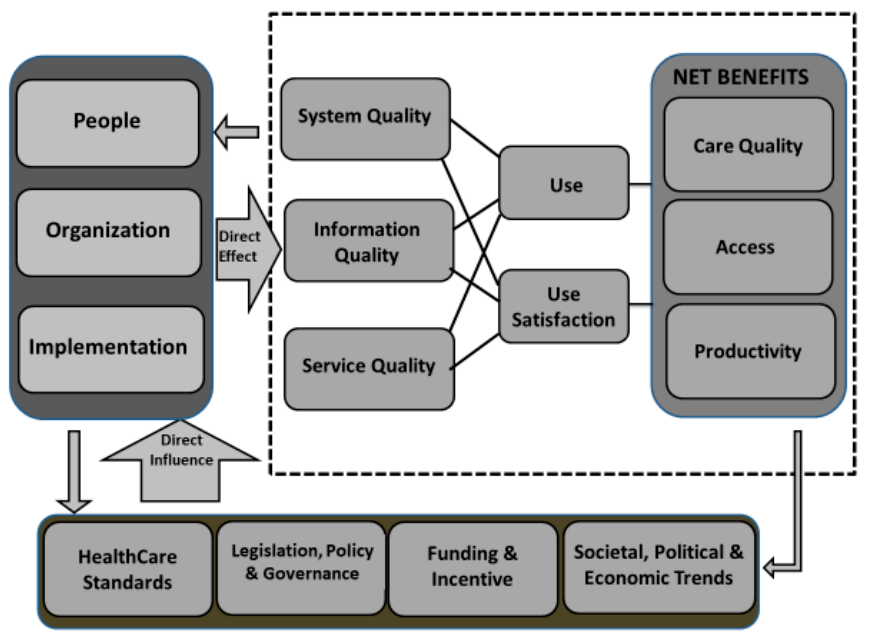
Figure 3. The schematic diagram of clinical adoption framework [12].